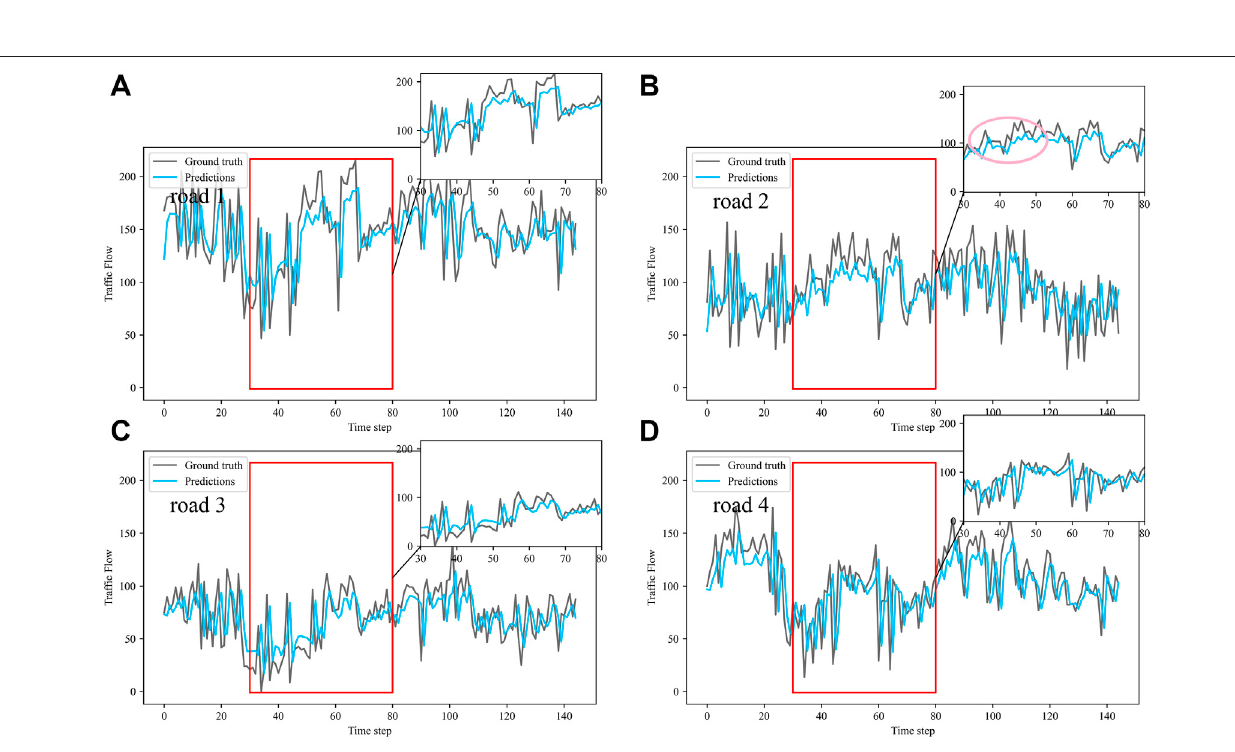
Frontiers in Bioengineering and Biotechnology |